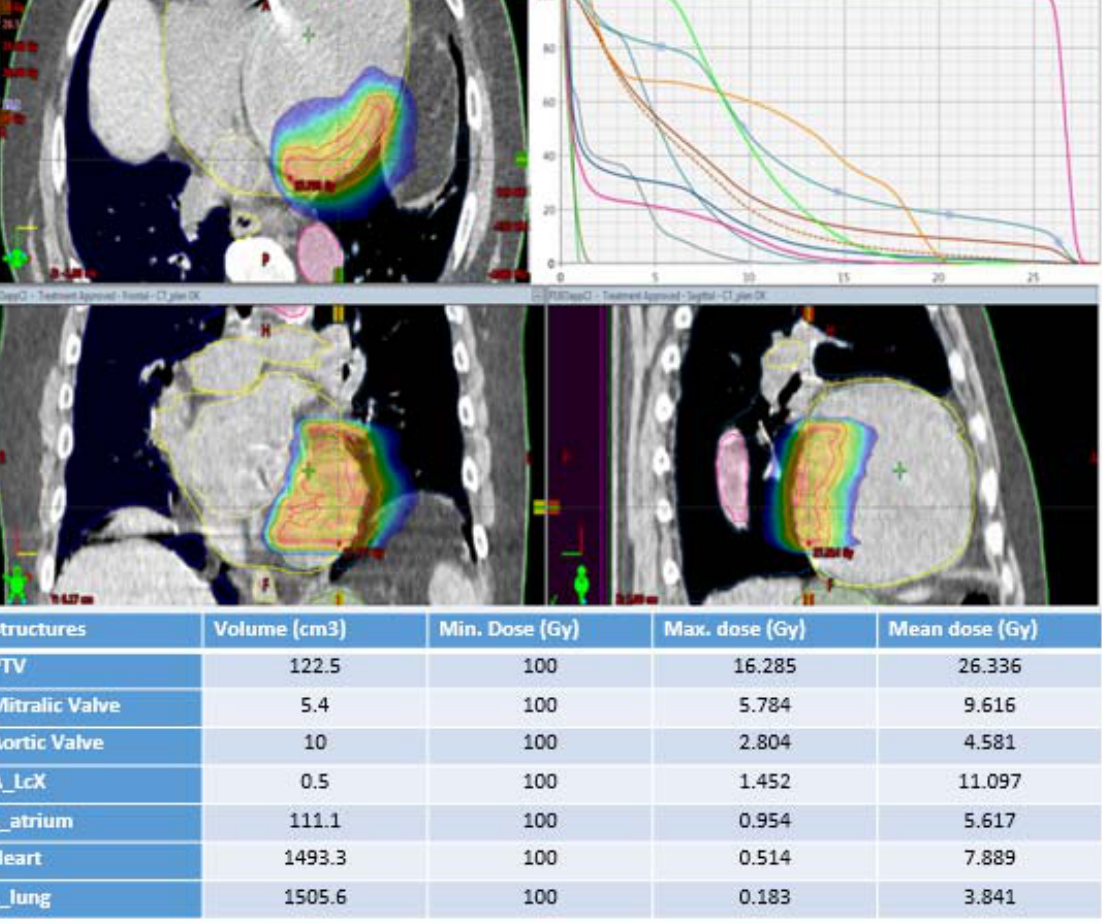
Figure 3. A dose distribution representation of radiotherapy planning and dose volume